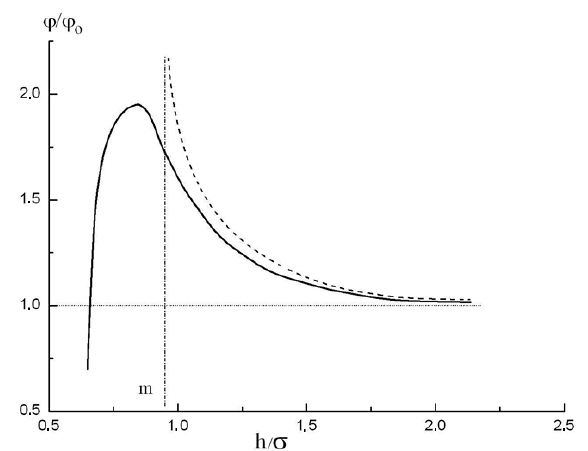
Figure 1. The excess of the potential energy of adsorbate molecules in a pore ϕ with respect to the potential energy of molecules over the infinite plane ϕ 0 with relative pore size h/ σ (solid curve). Also shown are: the analytical approximation, Equation (7) (dashed curve); the schematic asymptotic of this analytical approximation at (h/ σ ) → m (vertical dotted line); and the asymptotic at high h/ σ (horizontal dotted line).